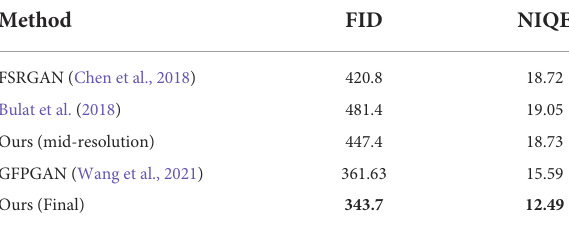
TABLE 3 Quantitative comparison of visual quality between other competing methods and